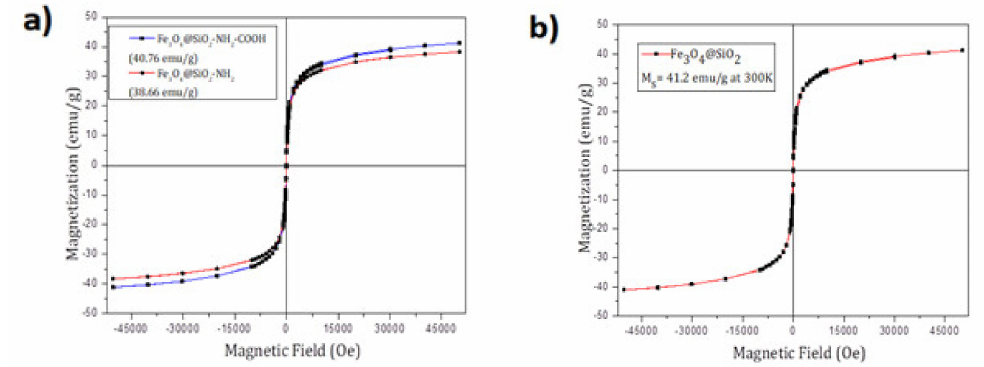
Figure 4. The hysteresis curve of Fe 3 O 4 @SiO 2 -NH 2 MNPs: 38.66 emu / g, Fe 3 O 4 @SiO 2 -NH 2 -COOH: 40.76 emu / g ( a ) and Fe 3 O 4 @SiO 2: 41.2 emu / g ( b